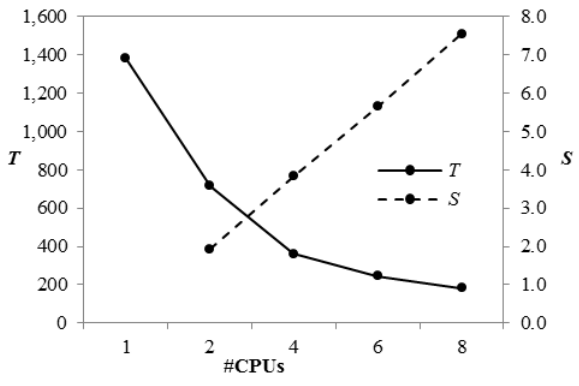
Figure 4: Execution time ( T) in seconds and Speedup ( S) for 1, 2, 4, 6 and 8 CPUs.